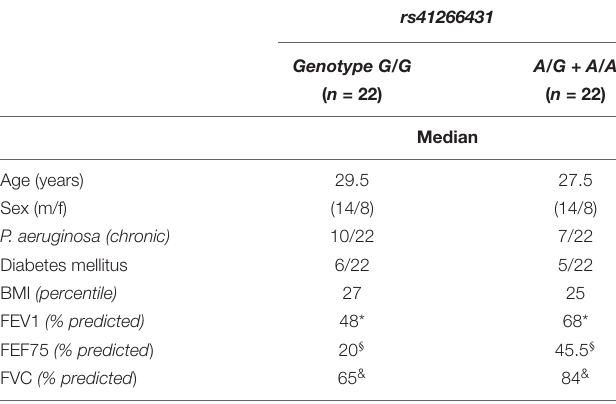
TABLE 3 | Characteristics of matched